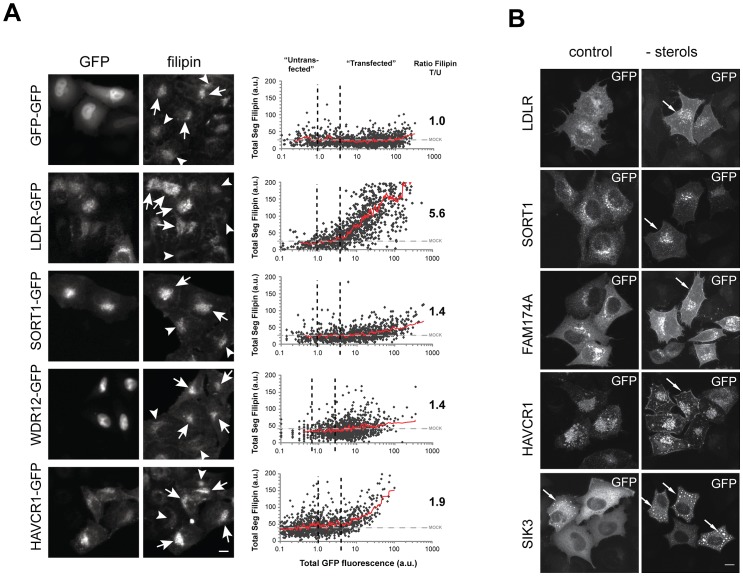
Impact on FC levels and subcellular localization of GFP–tagged candidate genes.(A) cDNAs encoding for indicated candidate genes linked to GFP were transiently expressed in Hela-Kyoto cells and impact on cellular FC levels was analyzed (see Materials and Methods, Figure S6 and Table S8 for comprehensive datasets). Arrows denote “transfected”, arrowheads “untransfected” cells. See Materials and Methods for definition of threshholds (dashed lines in graphs).Graphs depict total segmental filipin signal plotted against total cellular intensities in the GFP-channel. Each dot reflects one individual cell, trend lines are given in red. Numbers indicate mean ratios of FC in GFP-positive relative to non-expressing cells within the identical dish (n = 3–4 experiments). (B) Maximal projections of confocal stacks showing representative GFP-cDNA expressing cells under control and sterol-depleted conditions (see Materials and Methods). Arrows denote cellular compartments with increased signals upon sterol-depletion. Bars = 10 µm.